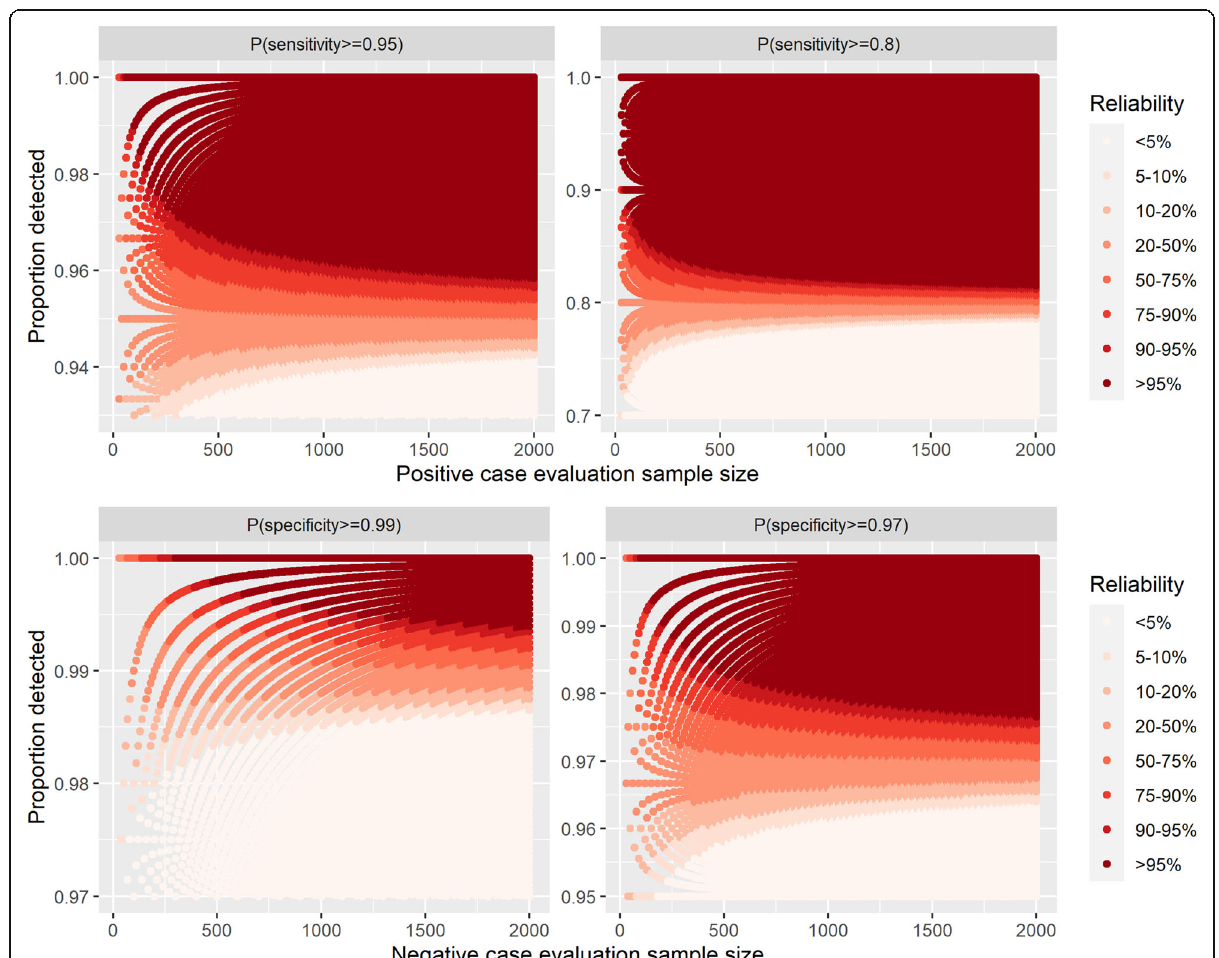
Fig. 1 Reliability for each of the Target Product Profiles (TPPs), where the reliability is the probability that the true value of the performance measure is greater than or equal to the TPP, given the result of the proportion of samples detected within a specified evaluation study sample